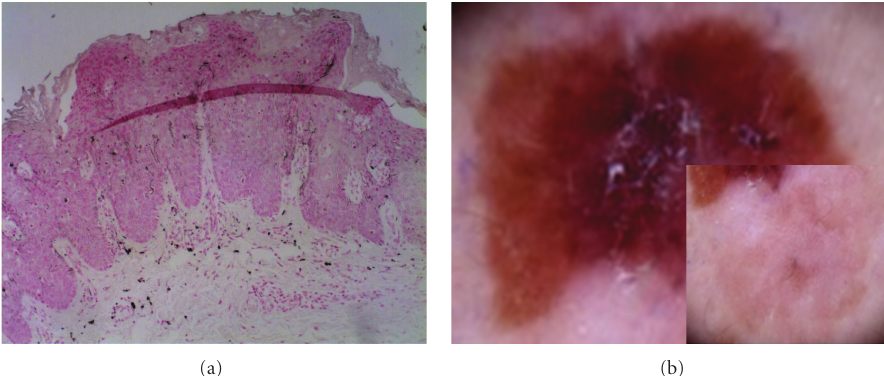
Figure 12: Case 1. Fontana Masson highlights pigment in dendritic melanocytes (a) correlating with pigmented peripheral streaks (b). The scarce pigment in keratinocytes correlates with a structureless brown pattern and the melanophages with the blue-gray areas and clusters of brown globules (bottom b).